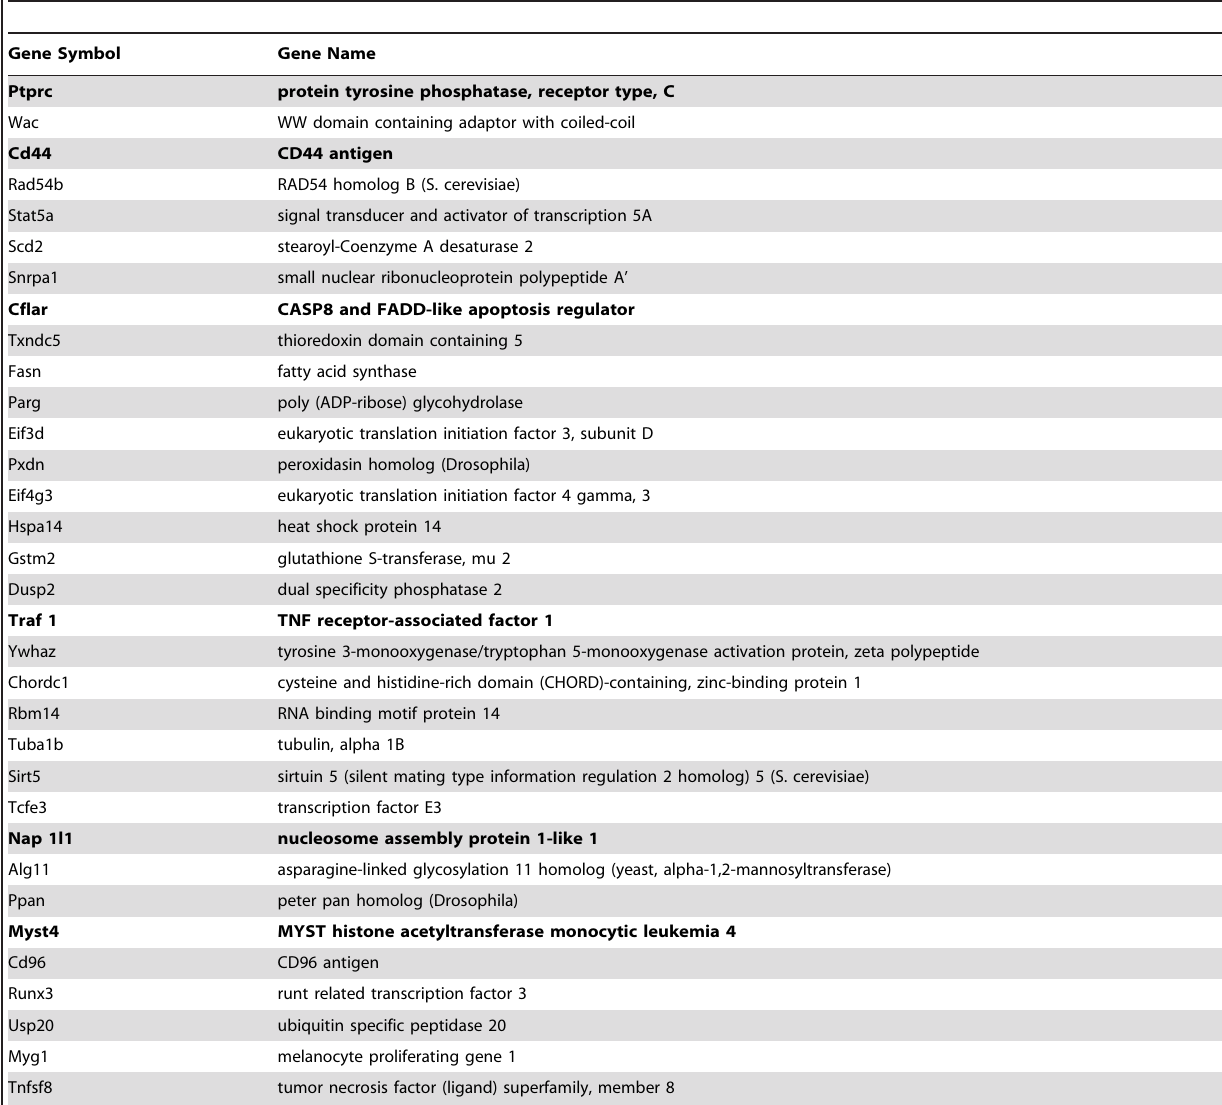
Table 1. Mouse orthologs of genes depending on hnRNPLL for alternative splicing [14].